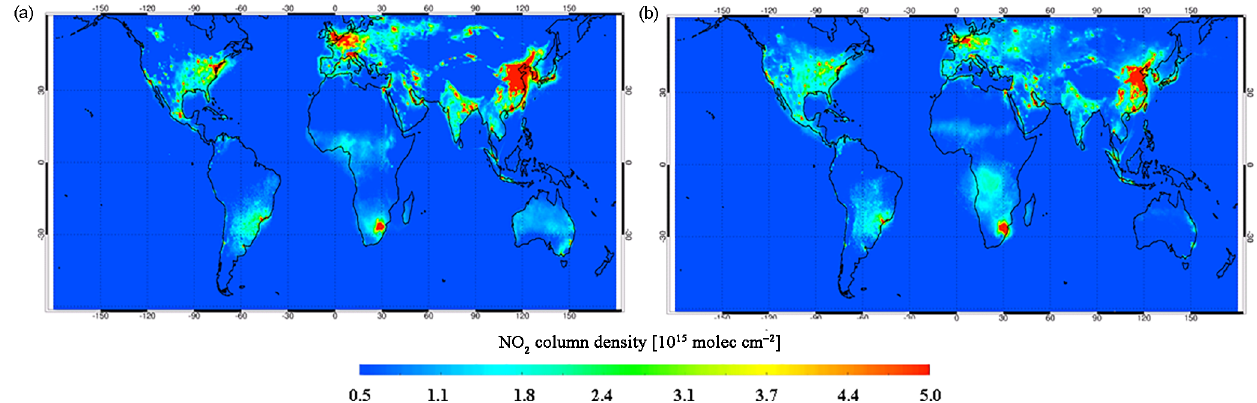
Figure 14. Monthly average tropospheric NO 2 columns from GDP 4.9 for clear-sky conditions (cloud radiance fraction smaller than 0.5), measured by GOME-2A in February (a) and August (b) 2007–2016.